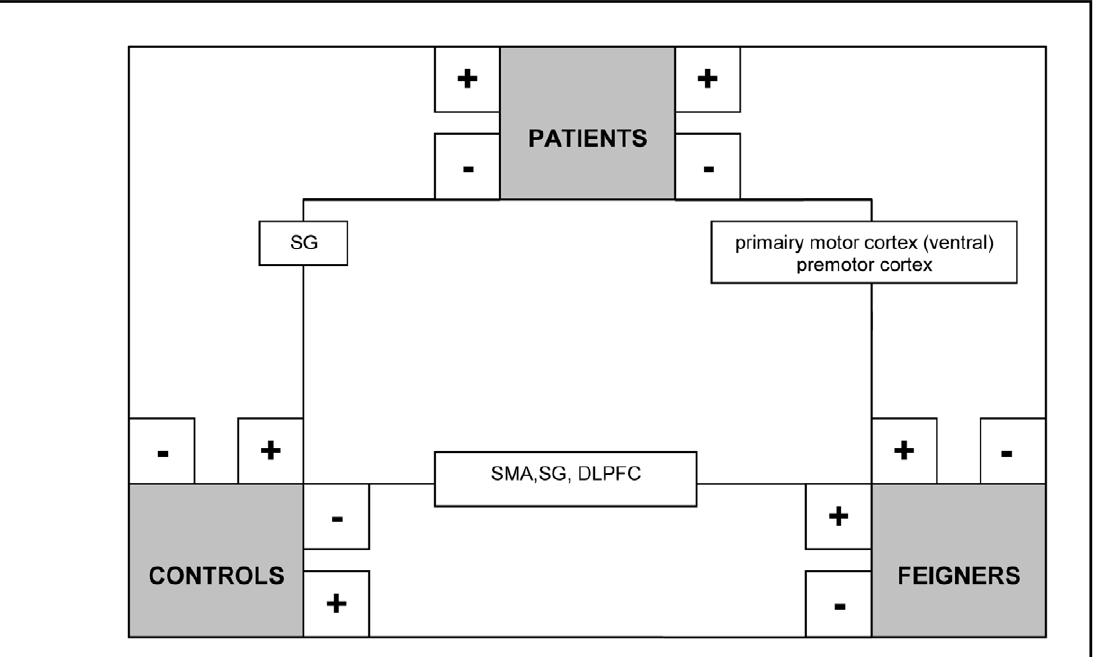
Figure 4. Schematic summary of significant clusters (P , 0.05, whole-brain corrected at cluster level; k . 200) in between-group comparisons (flipped data): movement imagery in the affected hand (analysis C). + =significantly more activated than -.